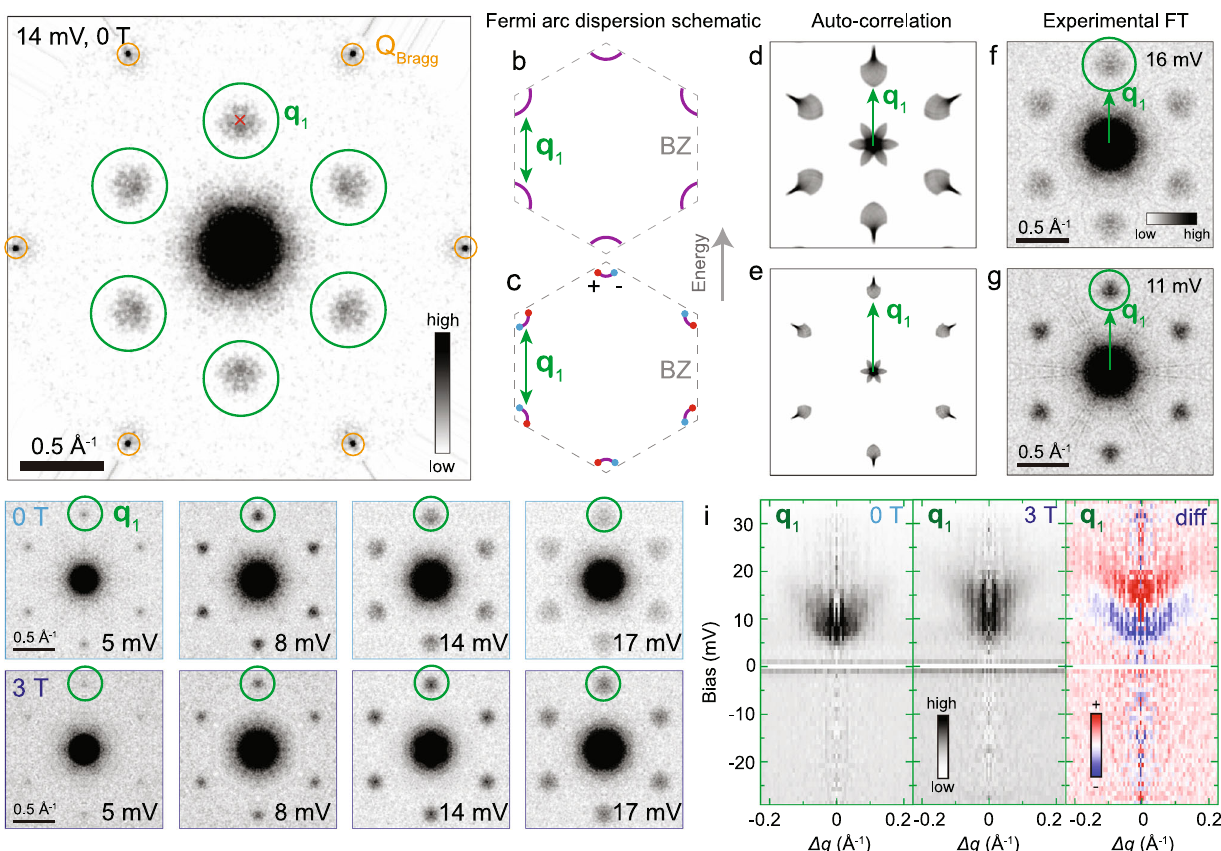
Fig. 4 Field-tunable signature of electron scattering and interference. a Sixfold symmetrized FT of L ( r , V ) = (d I /d V) /( I/V ) map at 14 mV. Orange circles enclose lattice Bragg peaks Q Bragg . The main scattering wave vectors are circled in green ( q 1 ). Constant energy contour schematic of Fermi arc dispersion with ( b ) large and ( c ) small Fermi arcs originating from pairs of Weyl nodes around each K point (red and blue circles in c ), and d , e corresponding auto-correlations. f , g Experimental L ( r , V ) maps at 16 mV and 11 mV, respectively, showing the scattering signature qualitatively consistent with those in ( d , e ). h Comparison of L ( r , V ) maps at zero fi eld (top row) and 3 T (bottom row). i Radially averaged linecuts of FTs of L ( r , V ) maps, starting at ( Q Bragg,1 + Q Bragg,2 )/3, focusing on the reciprocal space region denoted by the green circle in ( a ), at 0 T (left), 3 T (middle) and their difference (right). STM setup conditions: I set = 280 pA, V sample = 35 mV, V exc = 1